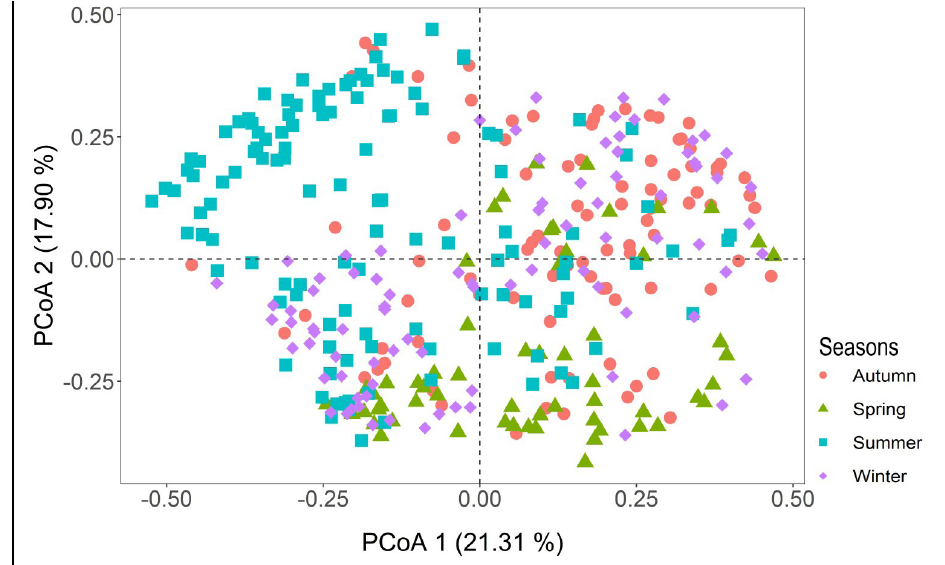
Figure 6. Ordering of the first two PCoA axes for the diet of Serrapinnus notomelas in the autumn, spring, summer, and winter seasons.